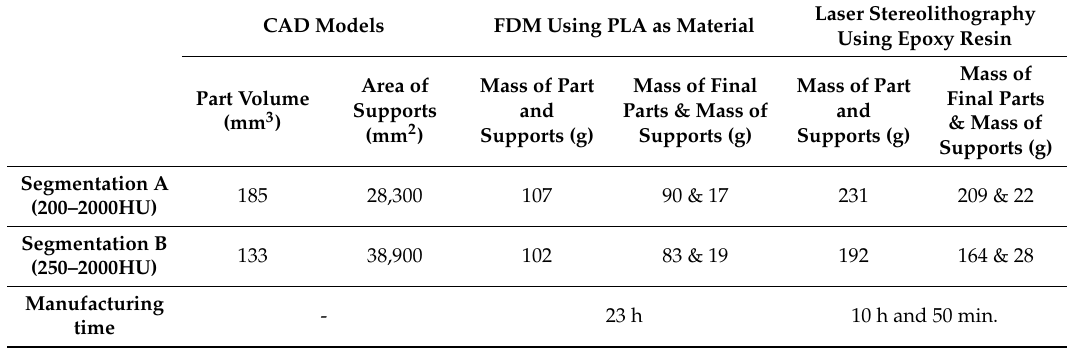
Table 3. Evaluation of design and prototyping alternatives: Quantitative data obtained from CAD models and from the actual manufactured prototypes with the di ff erent segmentations, materials, and technologies employed for present case of study.